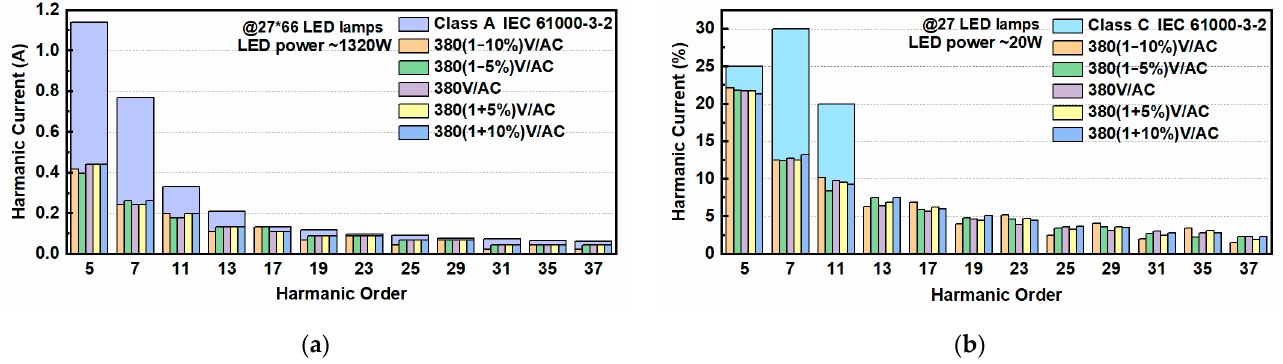
Figure 9. Harmonic current compared with Class A and Class C limits: ( a ) Class A comparison ( b ) Class C comparison.